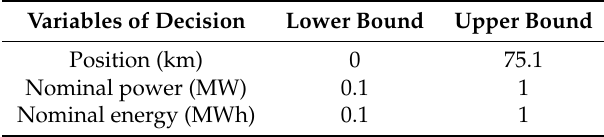
Table 9. Input parameters of the optimization algorithm.